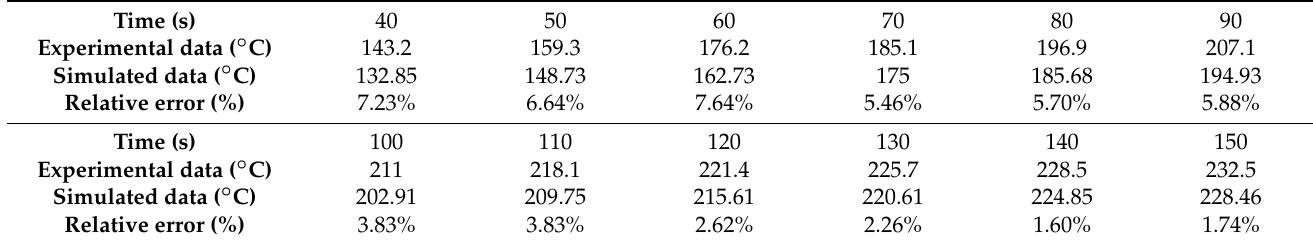
Table 8. Relative errors for measured and simulated coating temperatures ( η tot = 0.4).